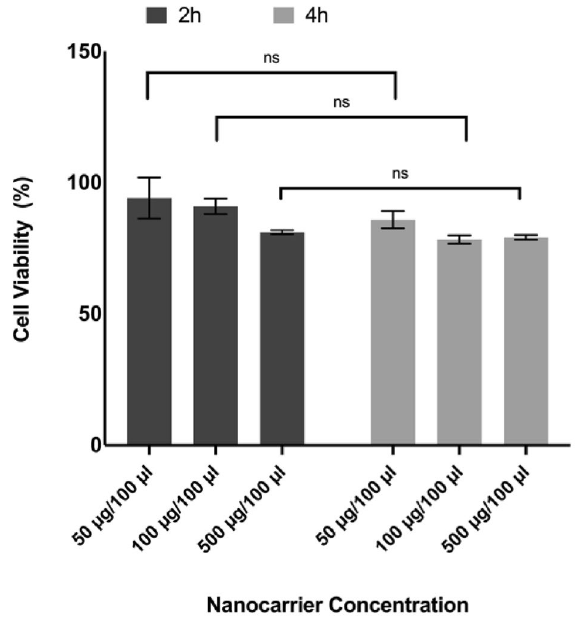
Figure 7. Effect of PF127(QD)-mAb nanocarrier formulation on the metabolic activity of dispersed human pancreatic islets, measured by the MTS assay. Cells were treated with nanocarriers at 50, 100, and 500 μg/100 µl concentration for 2 h and 4 h, in 10% FBS-containing cell culture media, and assayed 24 h post-treatment. Control cells were not treated with the nanocarriers; Data represent mean ± s.d. (n =